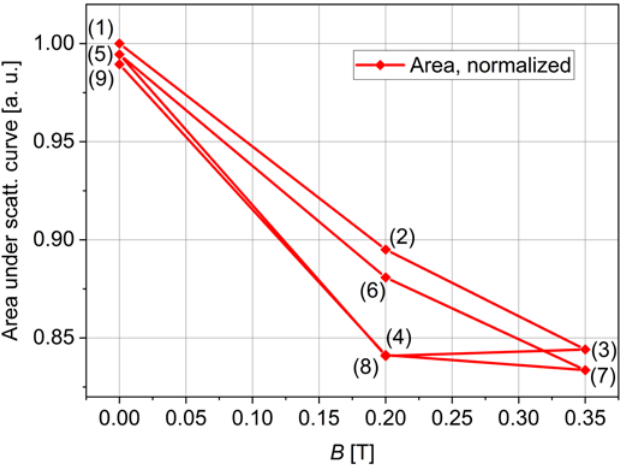
Figure 6. Normalized area under interpolated USANS scattering curve versus the applied magnetic field.